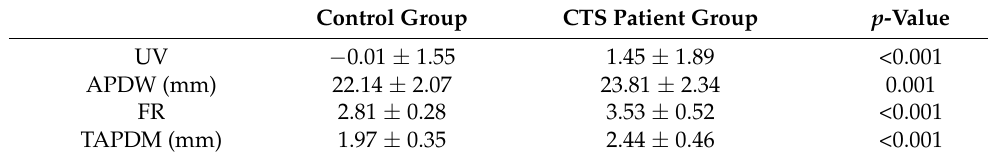
Table 5. Roentgenographic and ultrasonographic features in CTS patient and control groups.